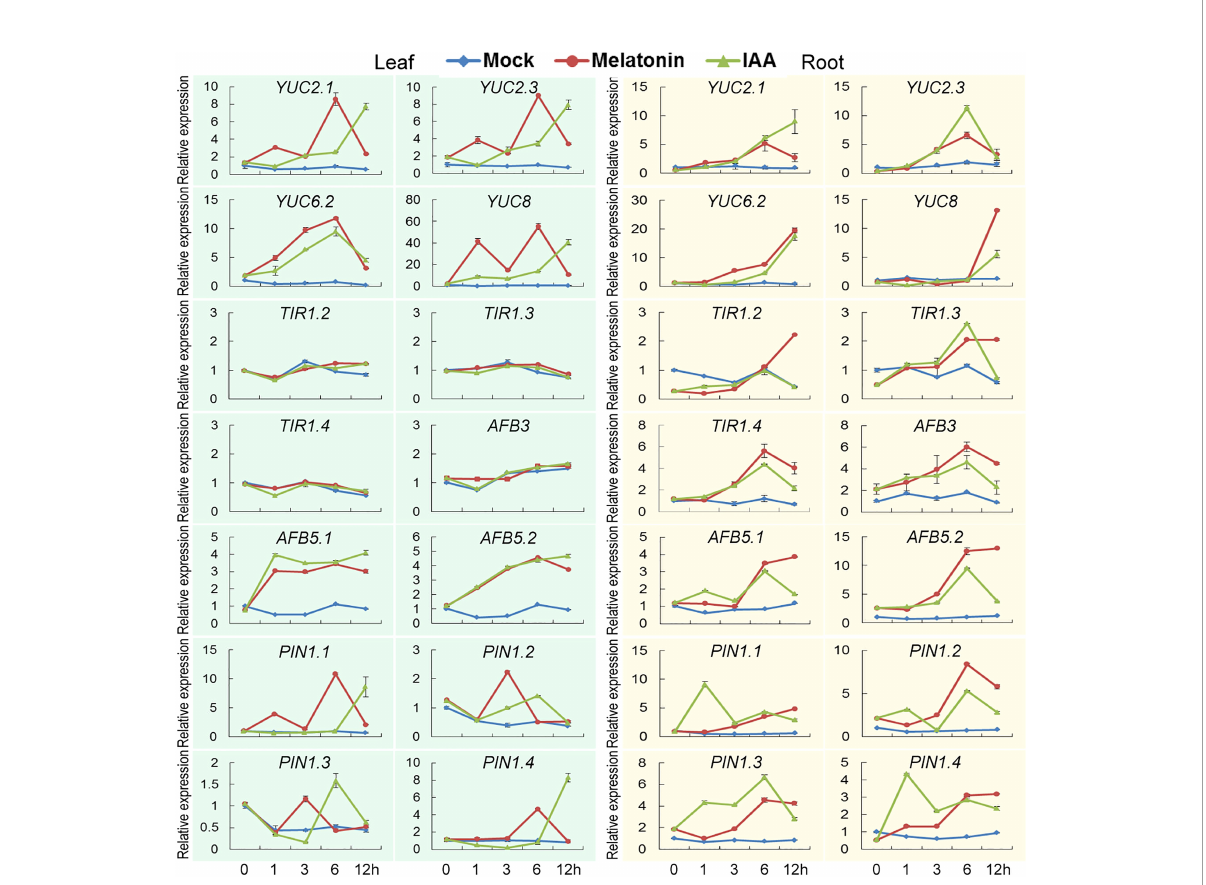
FIGURE 6 Veri fi cation of transcriptome analysis using quantitative PCR. Expression patterns of genes related to auxin biosynthesis and signaling pathways. Error bars indicate SD